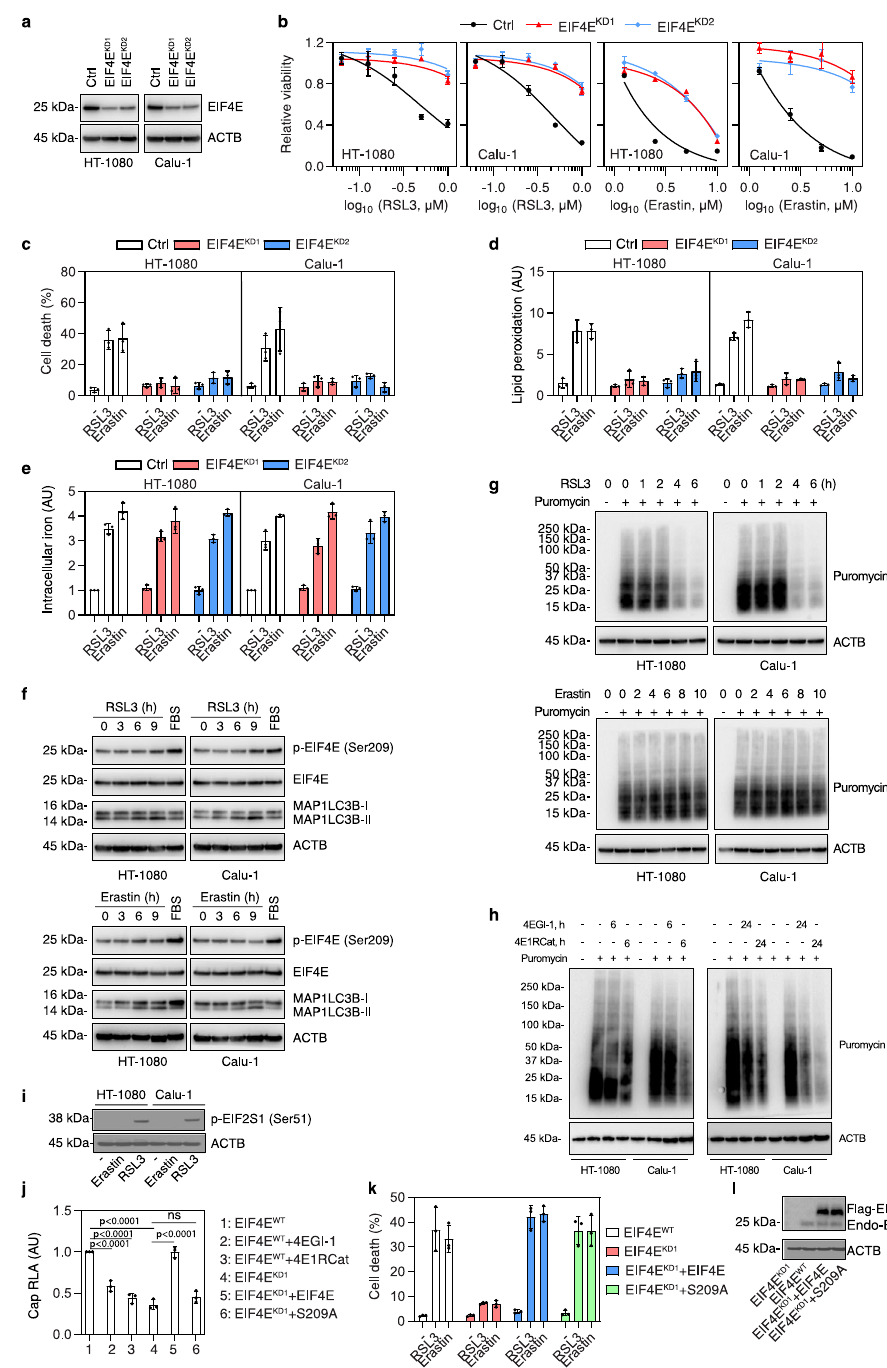
Fig. 2 | EIF4Emediatesferroptosisindependent ofprotein synthesis. a Western blot analysis of the indicated proteins in control and EIF4E-knockdown (EIF4E KD ) HT-1080 and Calu-1 cells. b Analysis of cell viability in the indicated cells following treatment with RSL3 or erastinfor 24h. Mean±SD, n =3. c Analysis of celldeath in the indicated cells following treatment with RSL3 (0.5 μ M) or erastin (5 μ M) for 24h. Mean±SD, n =3. d Analysis of lipid peroxidation in the indicated cells fol- lowing treatment with RSL3 (0.5 μ M, 4h) or erastin (5 μ M, 6h). Mean±SD, n =3. e AnalysisofironaccumulationintheindicatedcellsfollowingtreatmentwithRSL3 (0.5 μ M) or erastin (5 μ M) for 24h. Mean±SD, n =3. f Western blot analysis of the indicated proteins in HT-1080 and Calu-1 cells following treatment with RSL3 (0.5 μ M) or erastin (5 μ M). FBS: medium having 20% fetal bovine serum for 9h. g , h Western blot analysis of puromycylated peptides in HT-1080 and Calu-1 cells